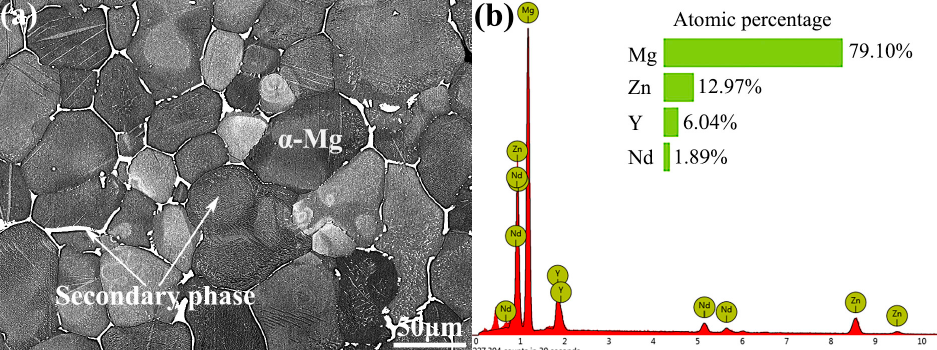
Figure 1. SEM micrograph of the heat-treated Mg–Zn–Y–Nd alloy ( a ) and EDS spectrum of the secondary phase ( b ).